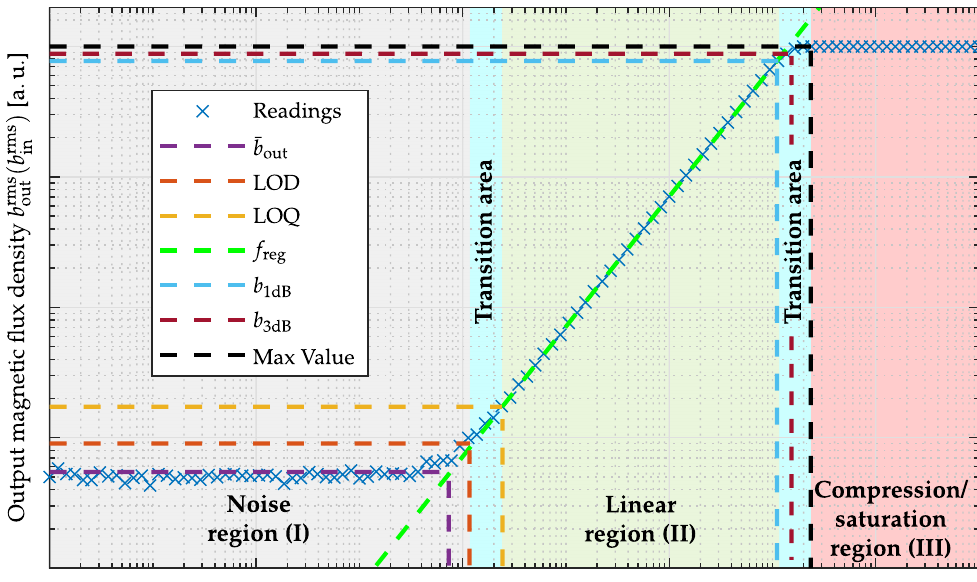
Figure 2. Input–Output–Amplitude–Relation with labeling of the typical regions (noise region (I), linear region (II) and compression/saturation region (III)). Transition areas are marked in cyan. Furthermore, characteristic quantities, mean value within noise region, Limit-of-Detection (LOD), Limit-of-Quantification (LOQ), 1-dB-compression-point , 3-dB-compression-point and maximum value are marked in different